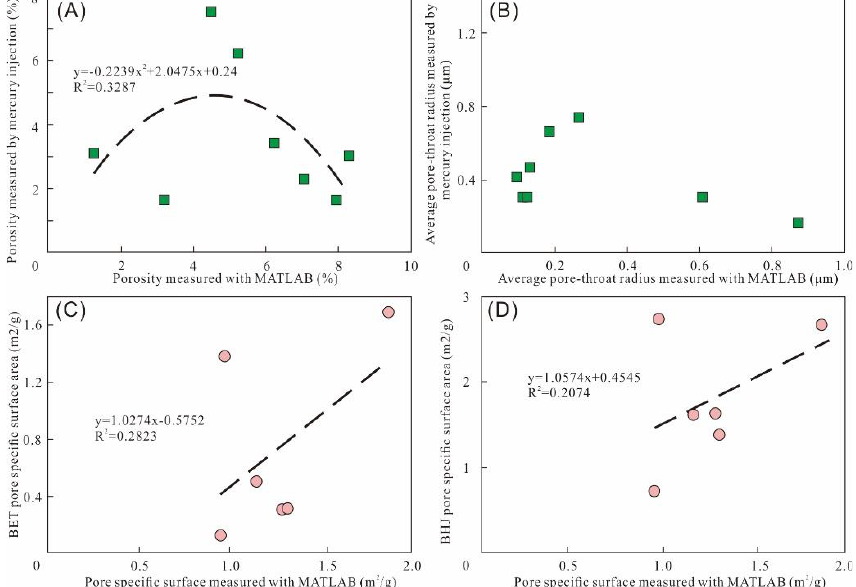
Figure 11. ( A ) The porosity was measured by image – algorithm quantitative analysis with the mer- cury injection data. ( B ) The average pore-throat radius was measured by image – algorithm quantitative analysis with the mercury injection data. The relationship between specific surface area measured by image – algorithm analysis with BET specific surface area ( C ) and BJH specific surface area ( D ) by N 2 adsorption experiment.